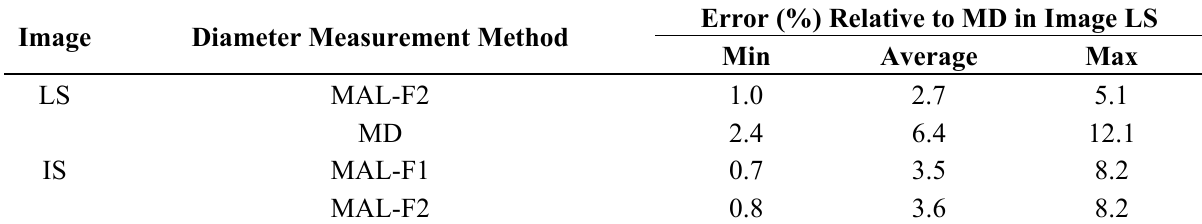
Table 3. Relative error in the diameter estimate: bright illumination case. Image